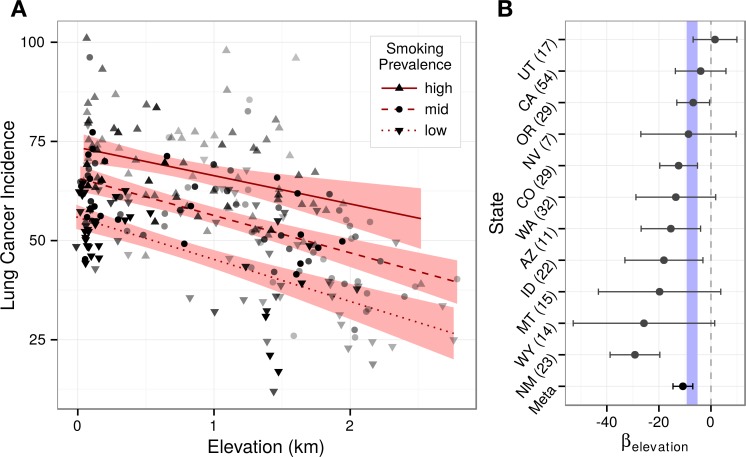
Elevation’s association with lung cancer is consistent across county strata.Stratification analyses provide no evidence for a smoking-elevation interaction or state-based confounding. (A) Lung cancer incidence (age-adjusted per 100,000) and elevation (km) are plotted for counties stratified into terciles by smoking prevalence. Counties were shaded by their regression weight, and a bivariate regression was fit for each stratum. The non-overlapping confidence bands (95%) illustrate the strong effect of smoking on lung cancer, while the approximately parallel slopes demonstrate the lack of an observable smoking-elevation interaction. (B) Lung cancer was regressed against elevation and smoking for each state. State-specific elevation coefficients are plotted with 95% confidence intervals. Ten of eleven states displayed negative coefficients. State-specific elevation coefficients were meta-analyzed. The resulting 99% confidence interval overlaps the interval from the optimal best subset model shown in blue. The number of counties within each state analysis is indicated in parentheses.